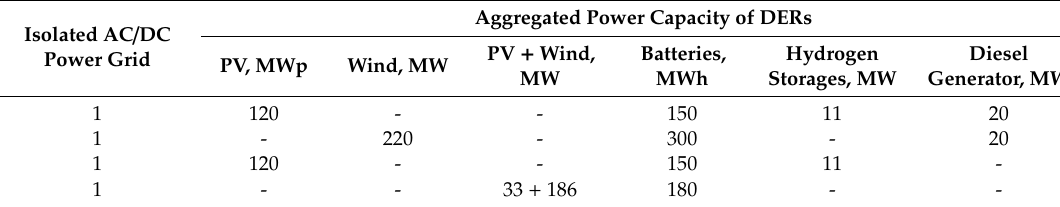
Table 1. The main parameters of isolated hybrid AC/DC power grids.